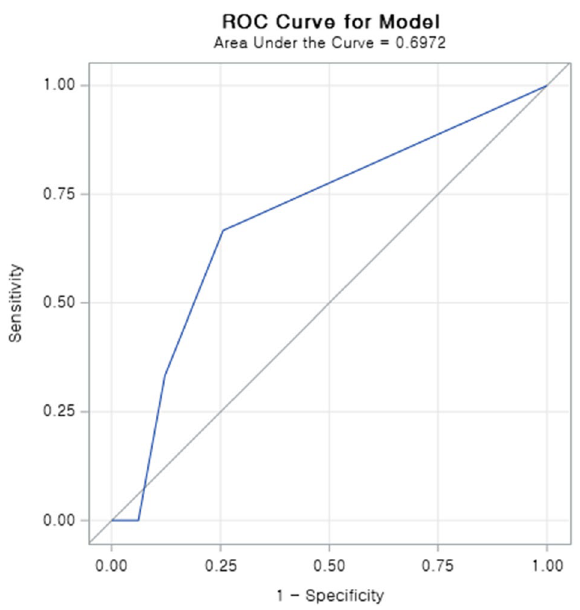
Figure 1. Receiver operating characteristic curve based on the level IIb score to predict level IIb lymph node metastasis (n = 135, AUC: 0.697, P <